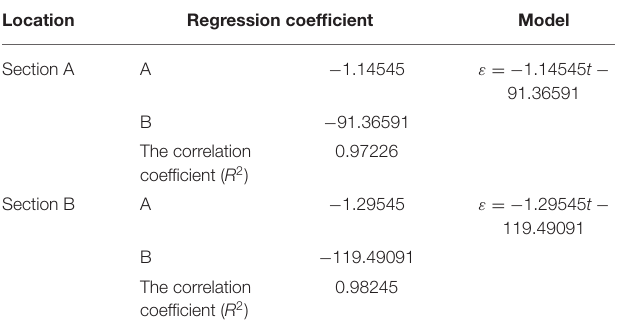
Table 10 : Comparing with the section B, the strain in the section A increases more slowly with temperature, which means that the temperature has less influence on the section